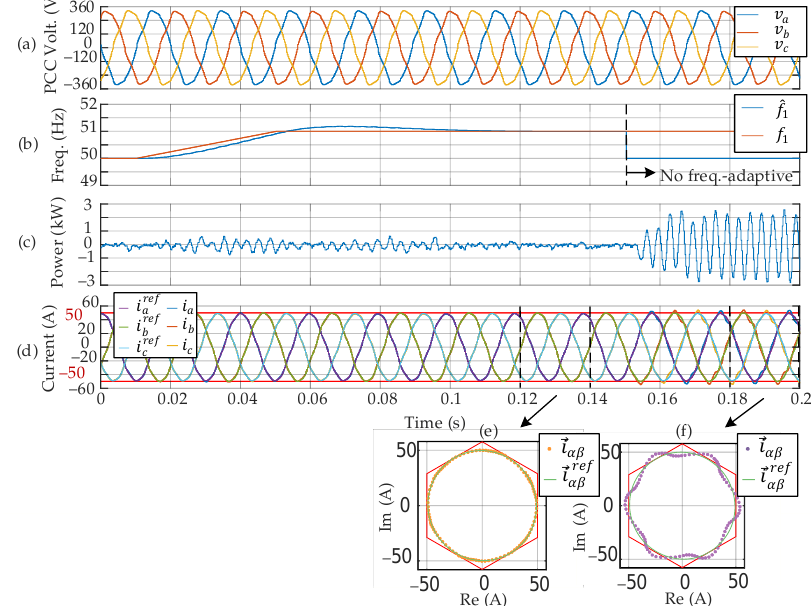
Figure 8. Analysis of frequency-adaptive scheme: ( a ) PCC voltage; ( b ) Estimated (cid:98) f 1 and real f 1 FPS; ( c ) Power exchange at the PCC; ( d ) Current at the PCC; and trajectory in the complex plane of the current (cid:126) i αβ and its reference (cid:126) i ref with ( e ) frequency-adaptive scheme ( f ) non αβ